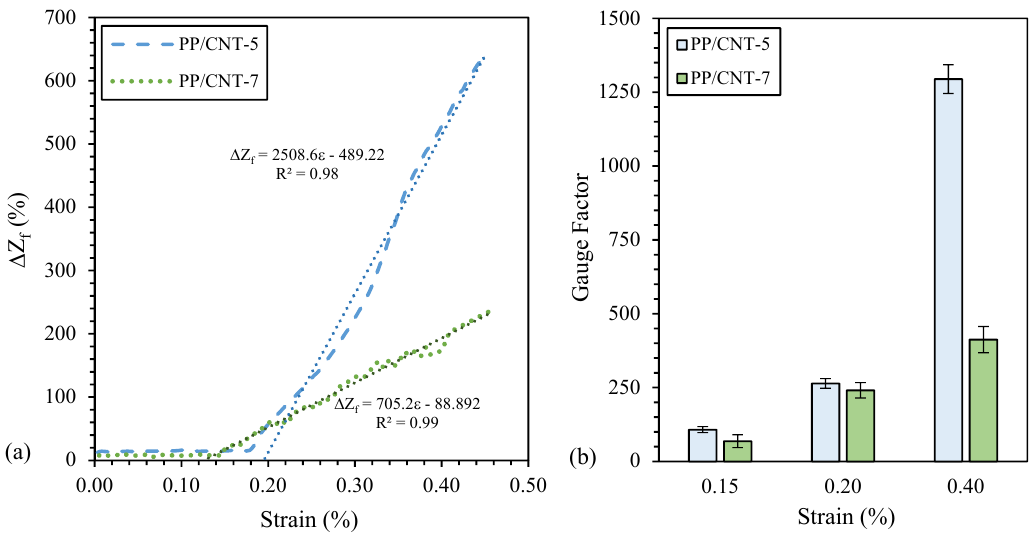
Figure 13: a) fractional change in electrical impedance (  Z f ) as a function of strain and b) Gauge Factor (GF) at Figure 13. ( a ) fractional change in electrical impedance ( ∆ Z f ) as a function of strain and ( b ) fixed strains (i.e. 0.15, 0.20 and 0.40%, respectively) for PP/CNT ‐ 5 and PP/CNT ‐ 7 nanocomposites. Gauge Factor (GF) at fixed strains (i.e., 0.15%, 0.20% and 0.40%, respectively) for PP / CNT-5 and PP / CNT-7